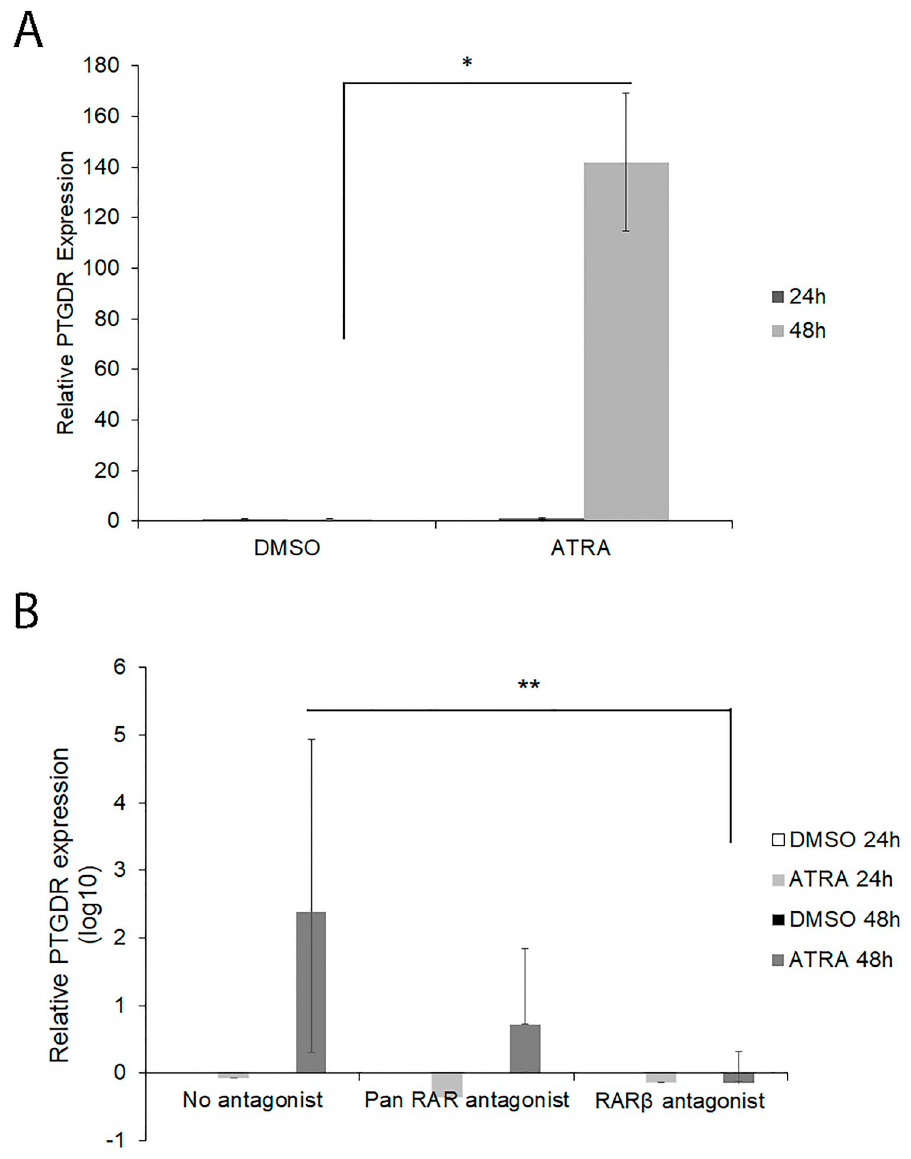
Fig 4. Quantitative real-time PCR analysis of PTGDR gene expression after ATRA or DMSO treatment in KU812 cells. A . KU812 cells were treated with 1 μ M ATRA or DMSO and collected after 24 and 48h followed by qPCR analysis as above mentioned. Data are shown as fold increase compared with DMSO (calibrator). � P < 0.05 for ATRA treated cells versus DMSO after 48h (Student’s T-test). B . KU812 cells were pre-treated with 1 μ M of Pan RAR- antagonist (AGN 193109) or RAR β antagonist (CD 2665) 1 hour before induction with ATRA or DMSO for 24 and 48 h. Cells treated with ATRA or DMSO were used as control. Data are shown as Log10 fold increase compared with DMSO treated cells at the same conditions (calibrator). �� P < 0.01 for ATRA 48h no antagonist compared with ATRA 48h RAR β antagonist (Student´s T-test).